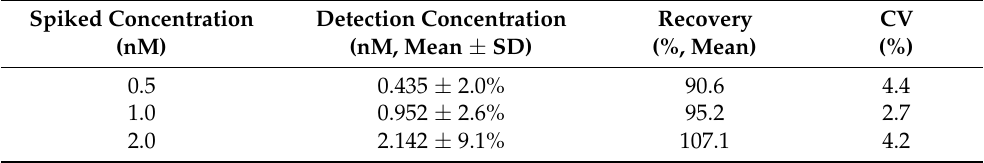
Table 2. Data of accuracy deviation by OA standard and relative standard